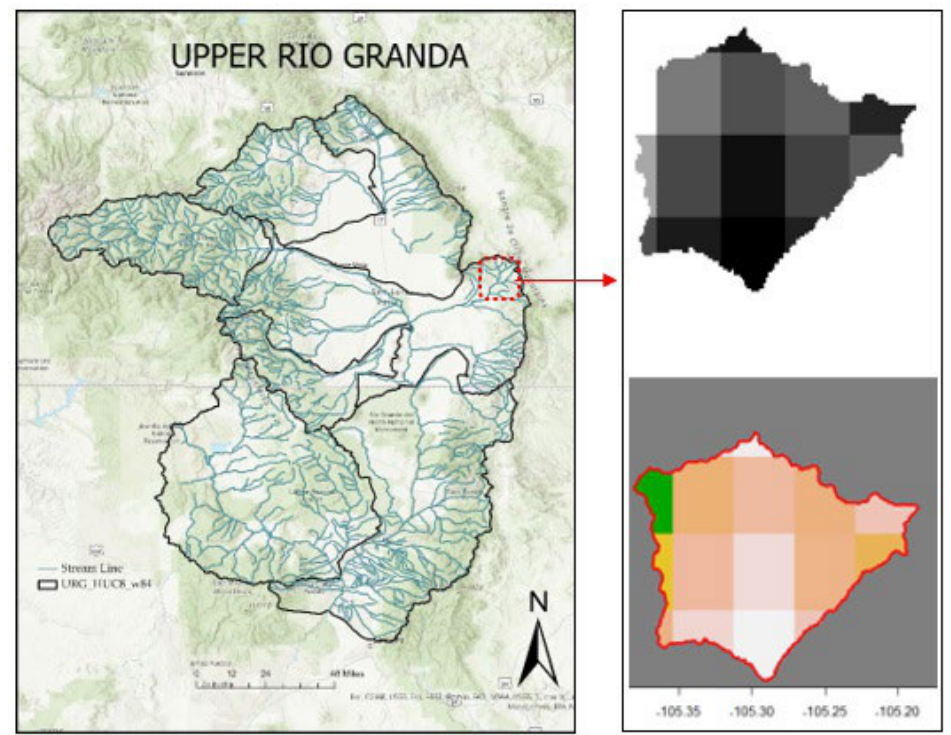
Figure 2. Clipped area in ArcMap ( upper right ) and R ( lower right ).